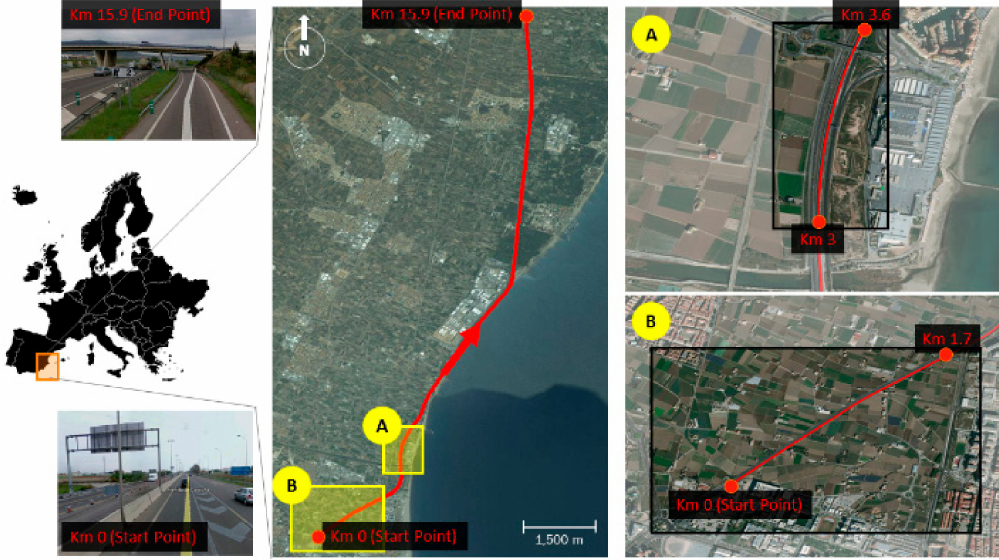
Figure 1. Route between the city of Valencia (start point) and Puzol (end point). The data plotted in the following figures correspond to the road sections shown in rectangles A and